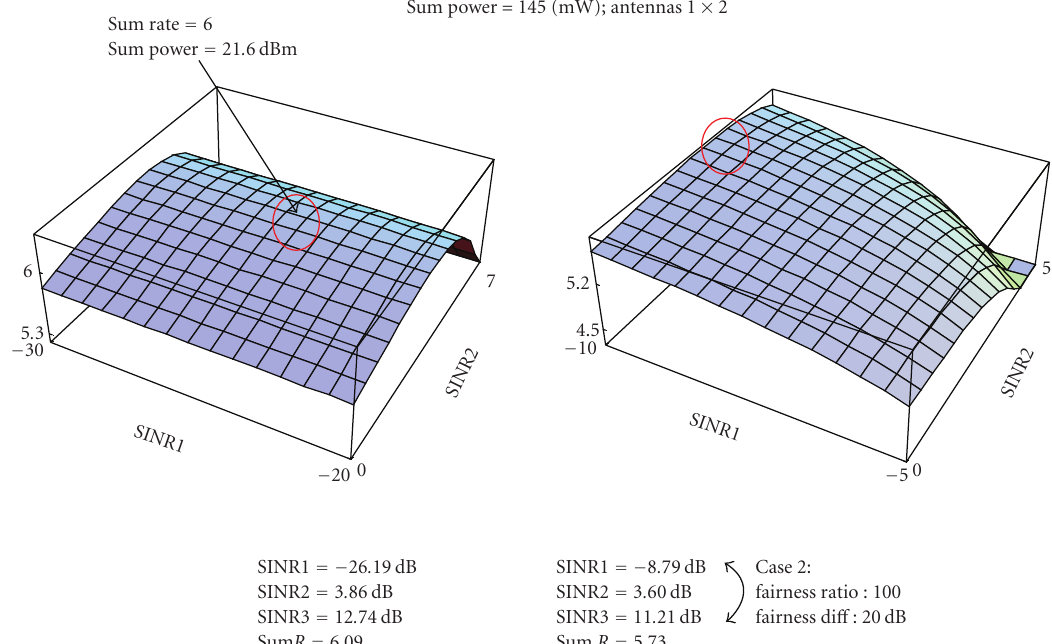
Figure 4: Capacity (sum rate) maximization while the total power is kept constant (here 21.6 dBm = 145 mW). Without fairness (Case 1, left) this sum power budget allows to reach 2 bps/Hz/cell (the same circled values as in 2), while in Case 2 (right), the overall sum rate is around 5% lower.